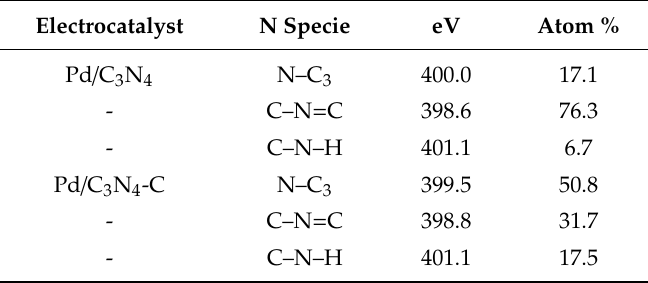
Table 3. Percentages of nitrogen species from spectra of N